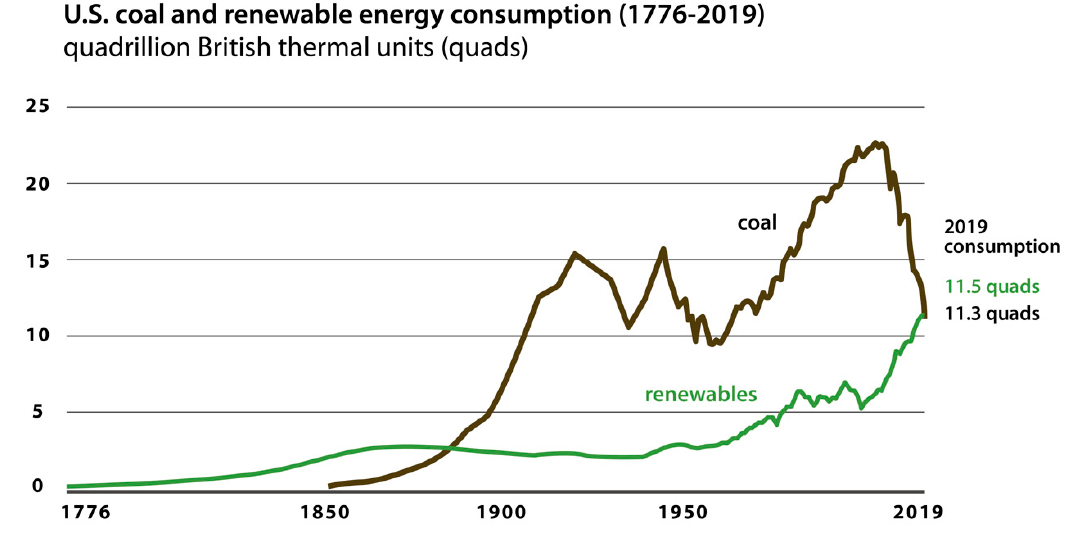
Figure 2. The discontinuity already being seen in power consumption in the US. Source: Redrawn from IEA [52].